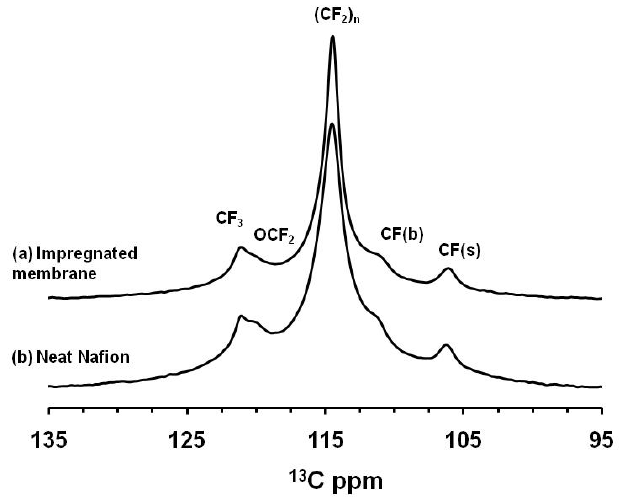
Figure 4. 125.6 MHz 19 F- 13 C CP/MAS SSNMR spectra of ( a ) impregnated membrane and ( b ) neat